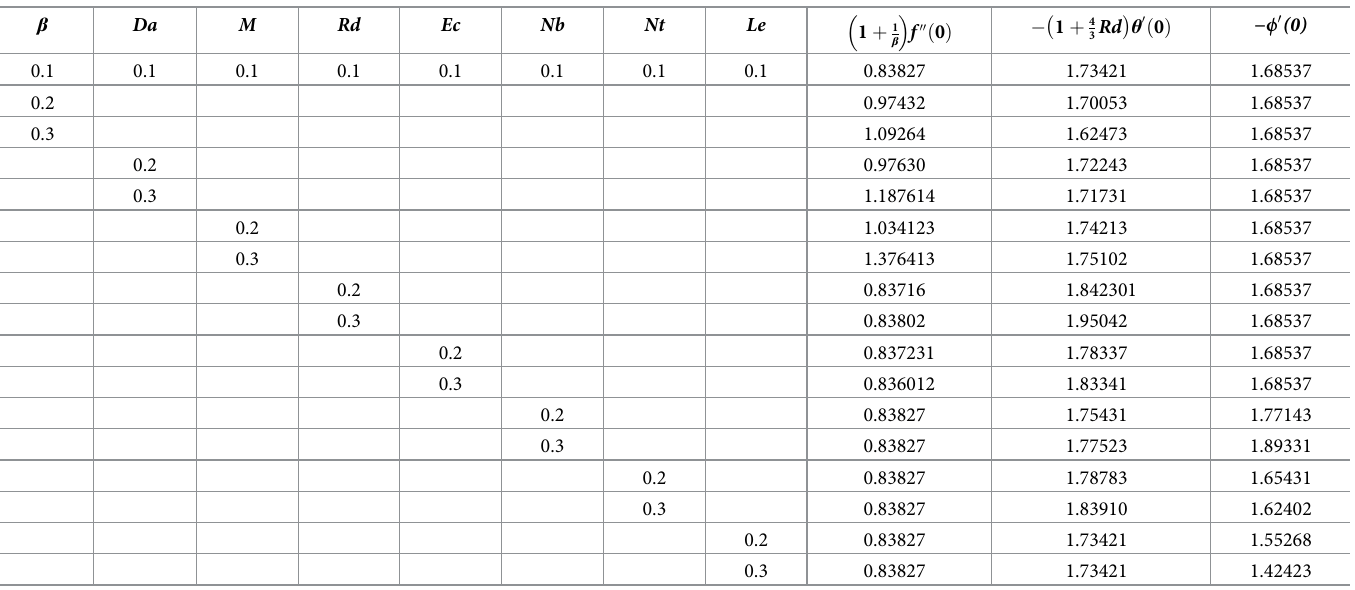
Table 2. Statistical assessments of skin friction, energy transition and mass transmission